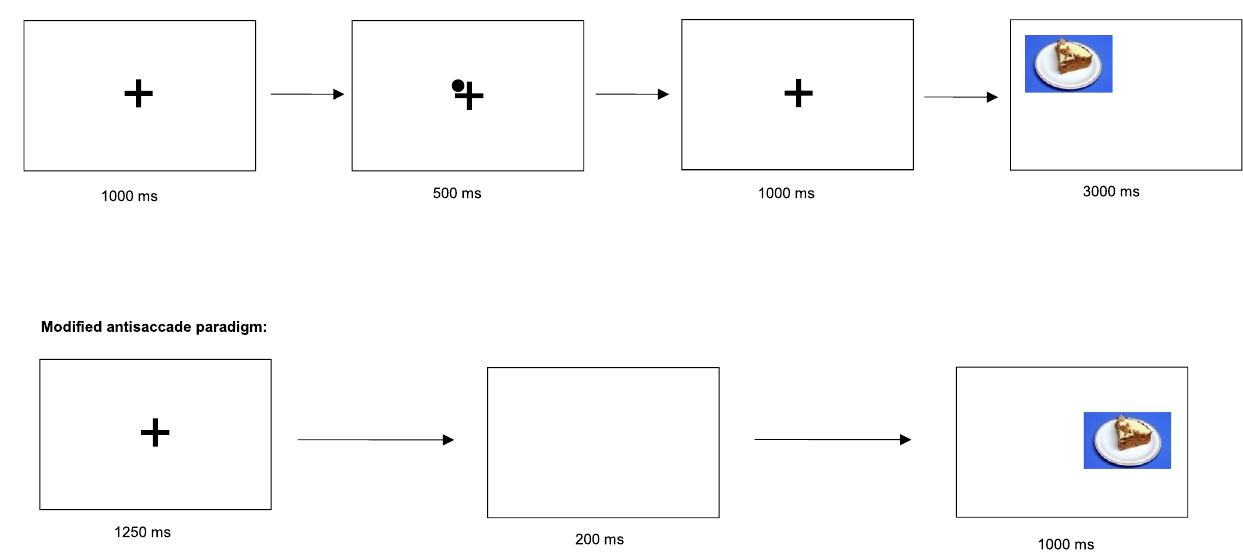
Figure 2. Schematic presentation of the cued exploration paradigm and the antisaccade paradigm. © Schag et al. (2015) 13 , slightly